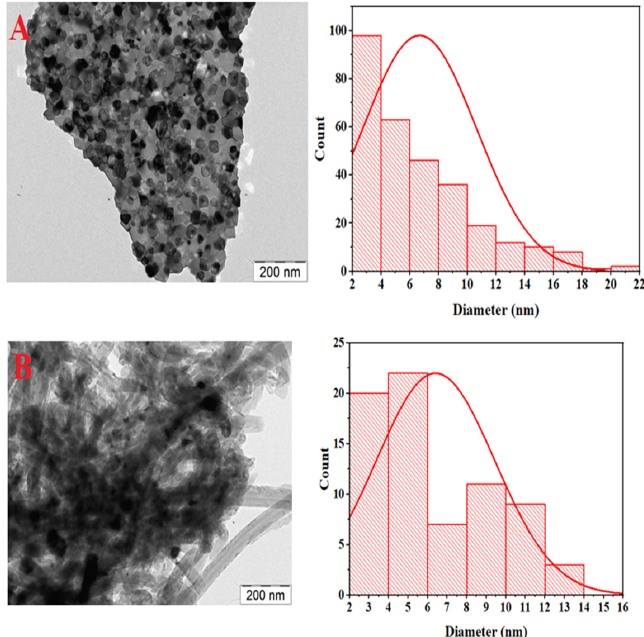
Figure 5. TEM micrographs and matching particle size distribution for fresh CeNi 0.9 Zr 0.1 O 3. ( A ) and used CeNi 0.9 Zr 0.1 O 3. ( B ) catalyst.